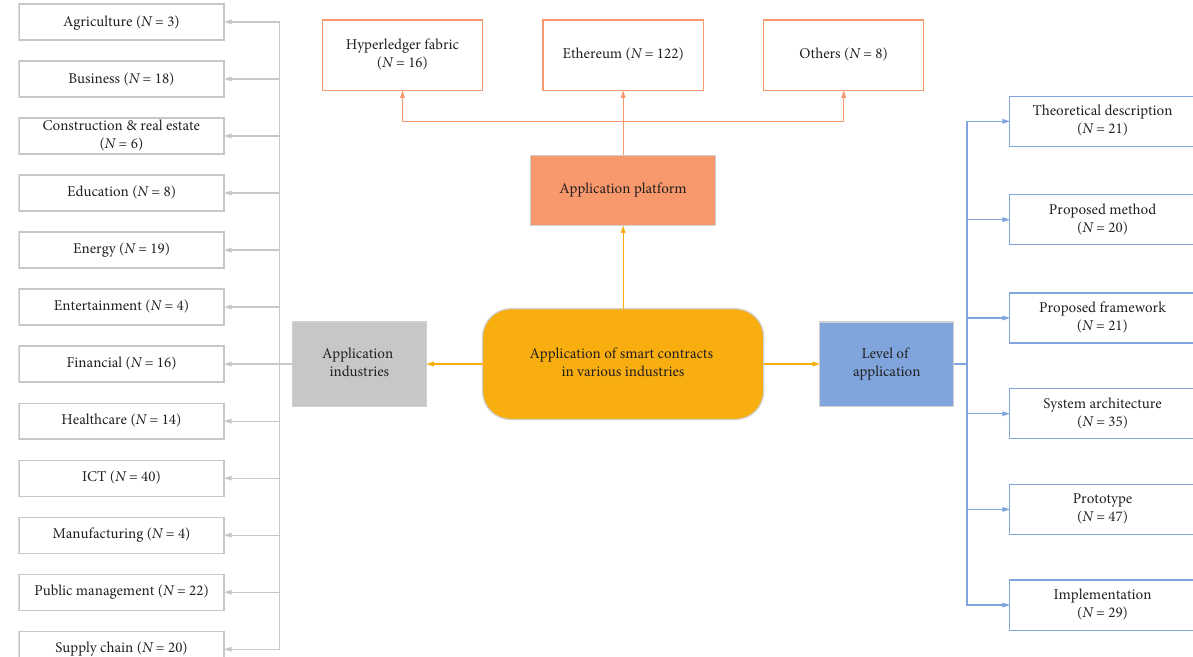
Figure 9: Classification of the application of smart contracts in various